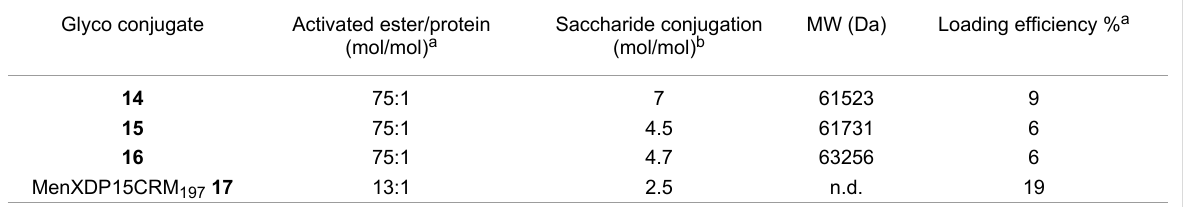
Table 1: Characteristics of the synthesized